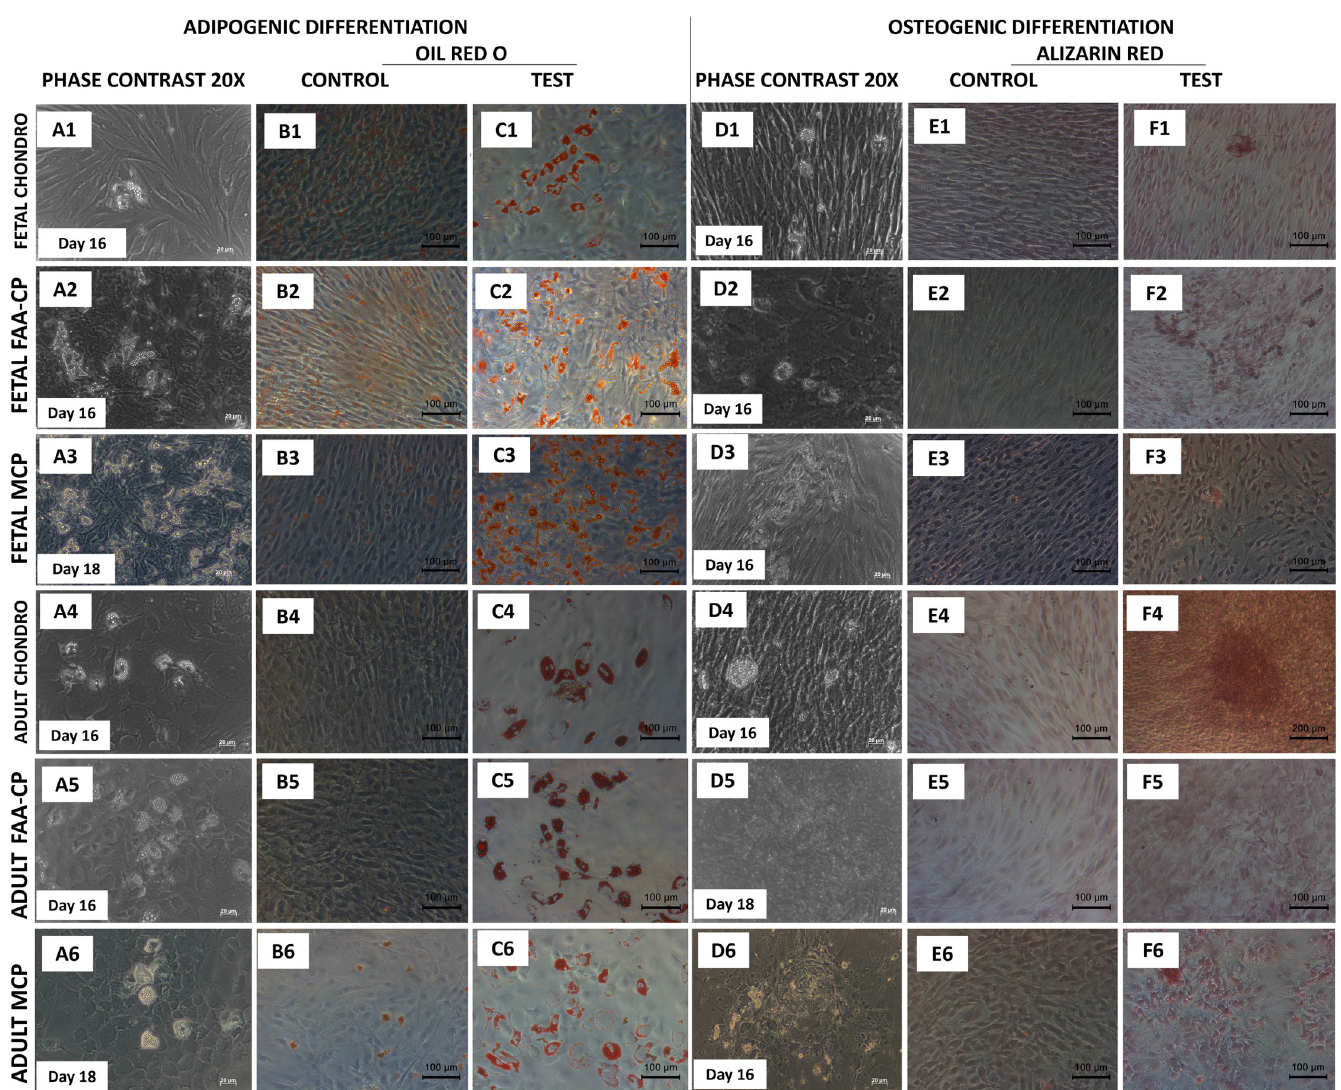
Fig 6. Representative phase contrast images and confirmatory staining following adipogenic and osteogenic differentiation. Unstained cells at day 18 during adipogenic (A1-A6) and osteogenic (D1-D6) differentiation and their confirmatory staining using Oil Red O (C1-C6) and Alizarin red (F1-F6). Magnification: 20X. All groups showed uptake of the Oil Red O stain indicative of lipid droplet accumulation and uptake of Alizarin red confirming calcium deposition, with the adult chondrocyte group displaying greater staining. Controls in all groups did not show any uptake of stain (B1-B6,